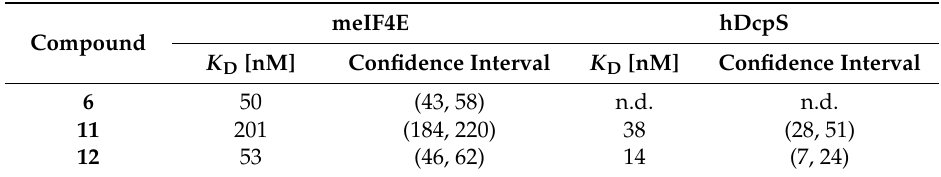
Table 2. K D values of the binding affinities for murine eIF4E and human DcpS determined by MST. K D values were calculated from triplicate experiments .